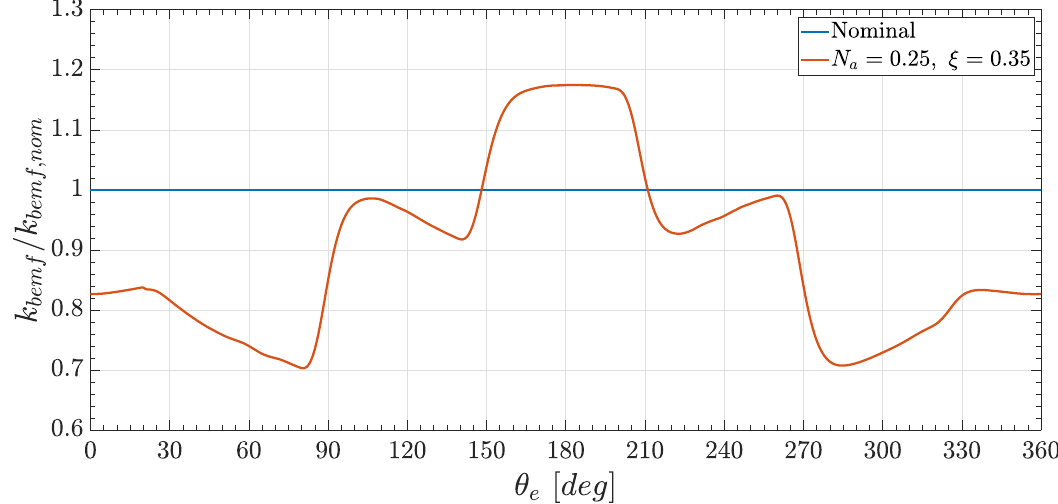
Figure 5. Normalized reconstructed back electromotive force (back-EMF) coefficient in nominal and faulty